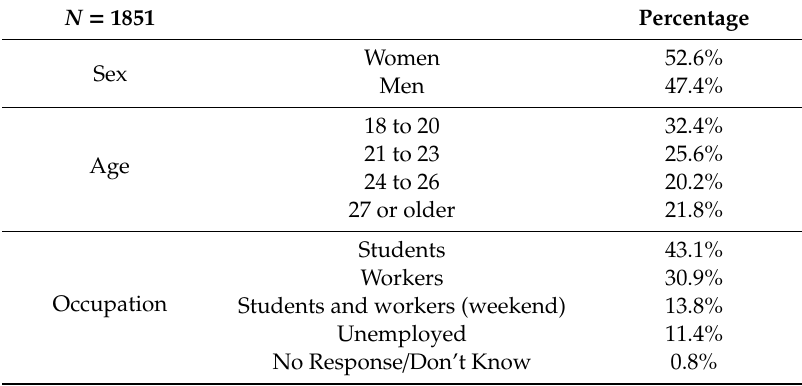
Table 1. Sociodemographic characteristics of the